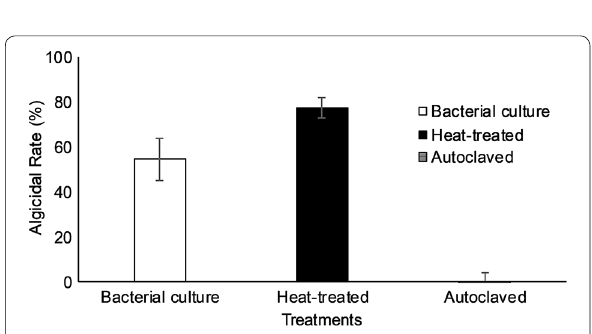
Fig. 2 Characterization of the algicidal compounds. All error bars indicate the SD of the three biological replicates